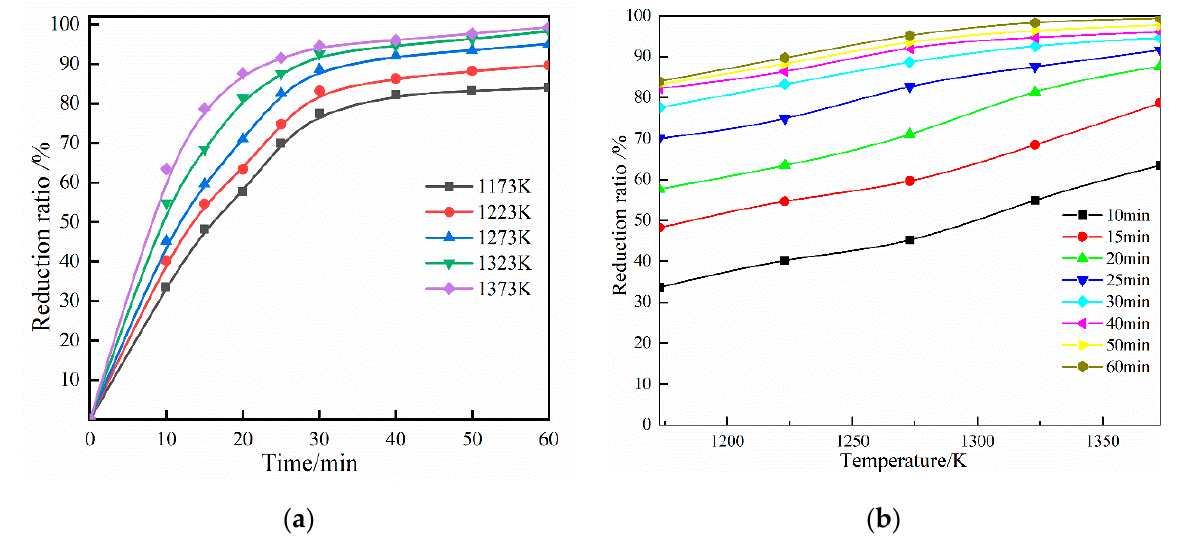
Figure 8. Effect of the reaction temperature ( a ) and reaction time ( b ) on zinc reduction ratio at 20 Pa.